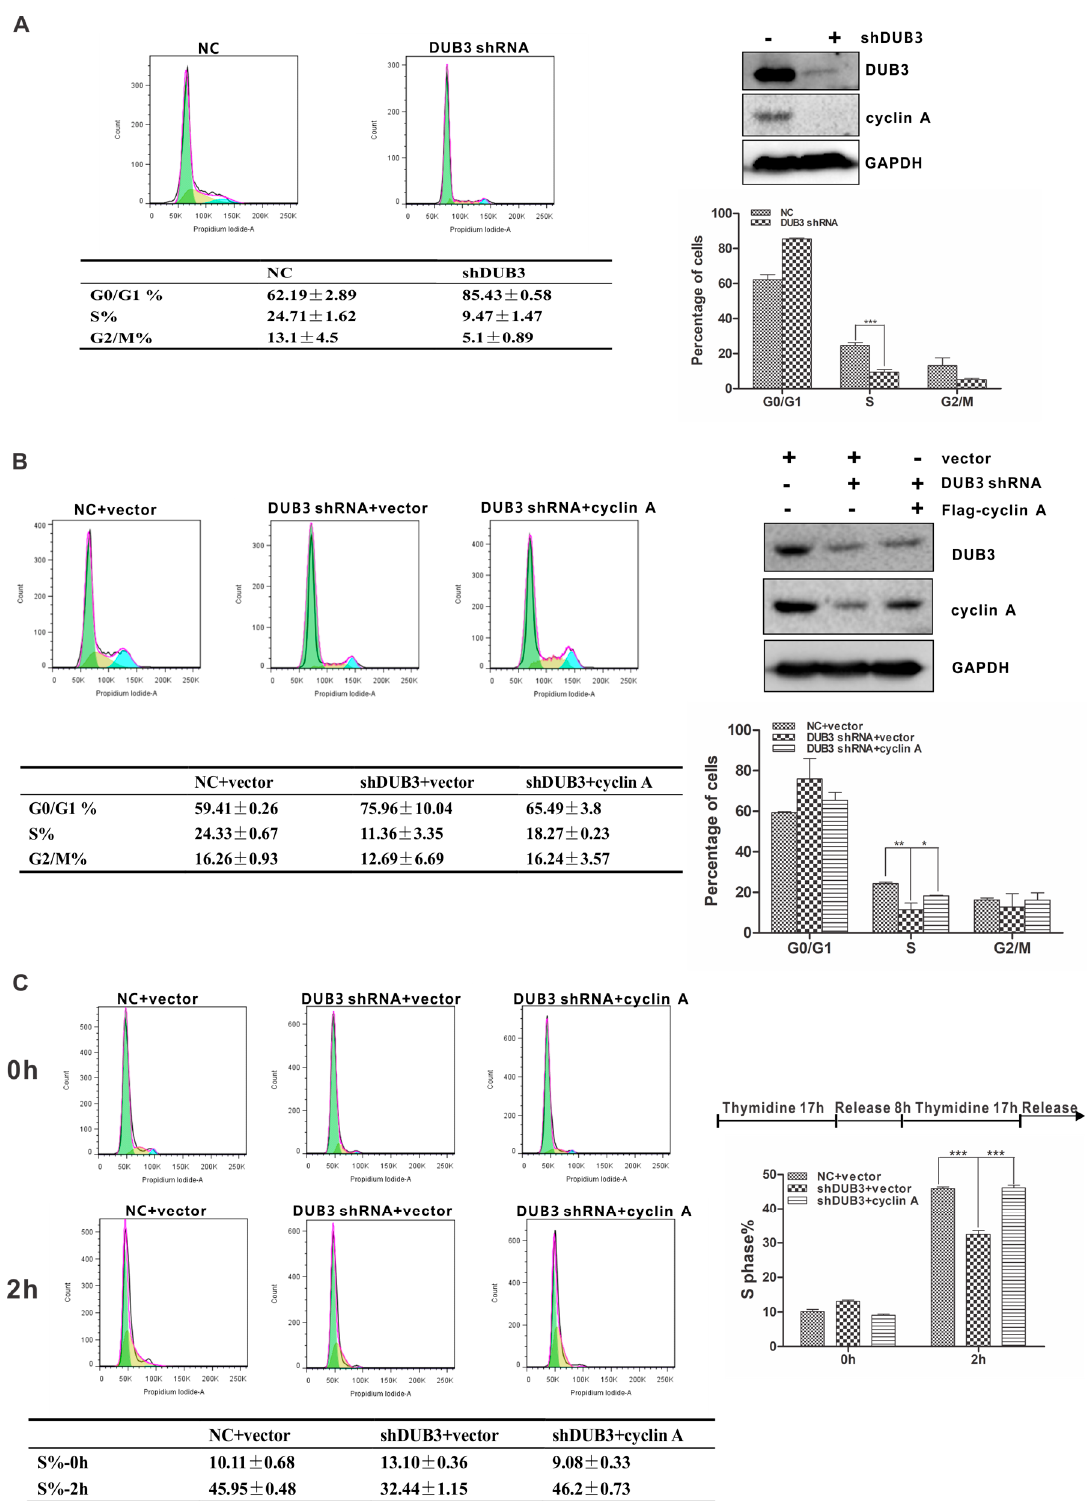
Figure 5. DUB3 regulates the G1/S transition in a cyclin A-dependent manner. ( A ) A549 cells infected with the indicated lentiviral shRNAs were stained with propidium iodide and analyzed using flow cytometry. Data represent the mean ( ± S.D.) of three independent experiments (*** p < 0.001). ( B ) A549 cells infected with the indicated lentiviral shRNAs with or without ectopic expression of cyclin A were stained with propidium iodide and analyzed using flow cytometry. Data represent the mean ( ±